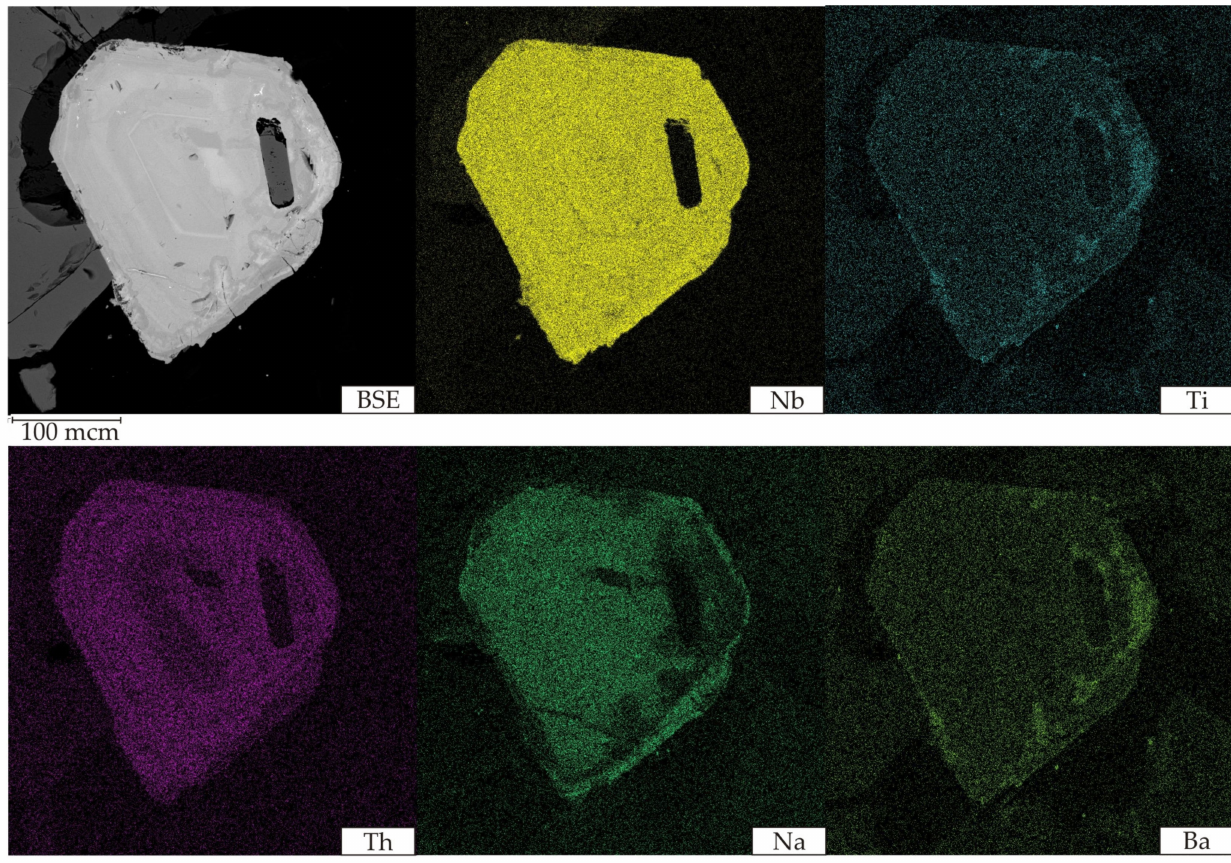
Figure 11. Monoelement maps of zonal grain in FOS 2 of the Arbarastakh massif (BSE—back scattering